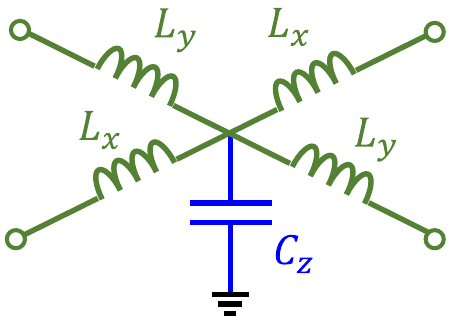
Figure 2: Unit cell circuit model for an anisotropic transmission line metamaterial (TL-MTM), with effective material parameters: 𝝁 = ( ̂ x ̂ x L + ̂ y ̂ y L = C ∕Δ x . ) ∕Δ x and 𝜀 x y z z function of the direction of propagation 𝜙 . For example, √ ( ) 𝜔 = kc 𝜇 𝜙 + 𝜇 ∕ ( 𝜀 𝜇 𝜇 2 𝜙 k n xn cos 2 yn sin zn xn yn ) for un- iaxial media (see Supplementary